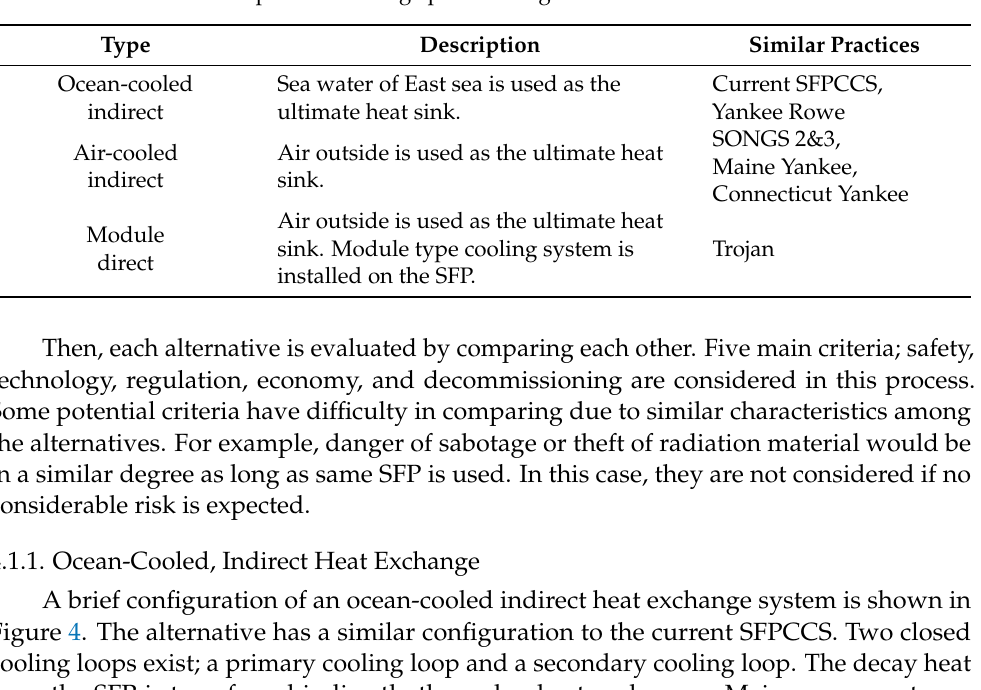
Table 12. Alternatives for spent fuel storage pool cooling